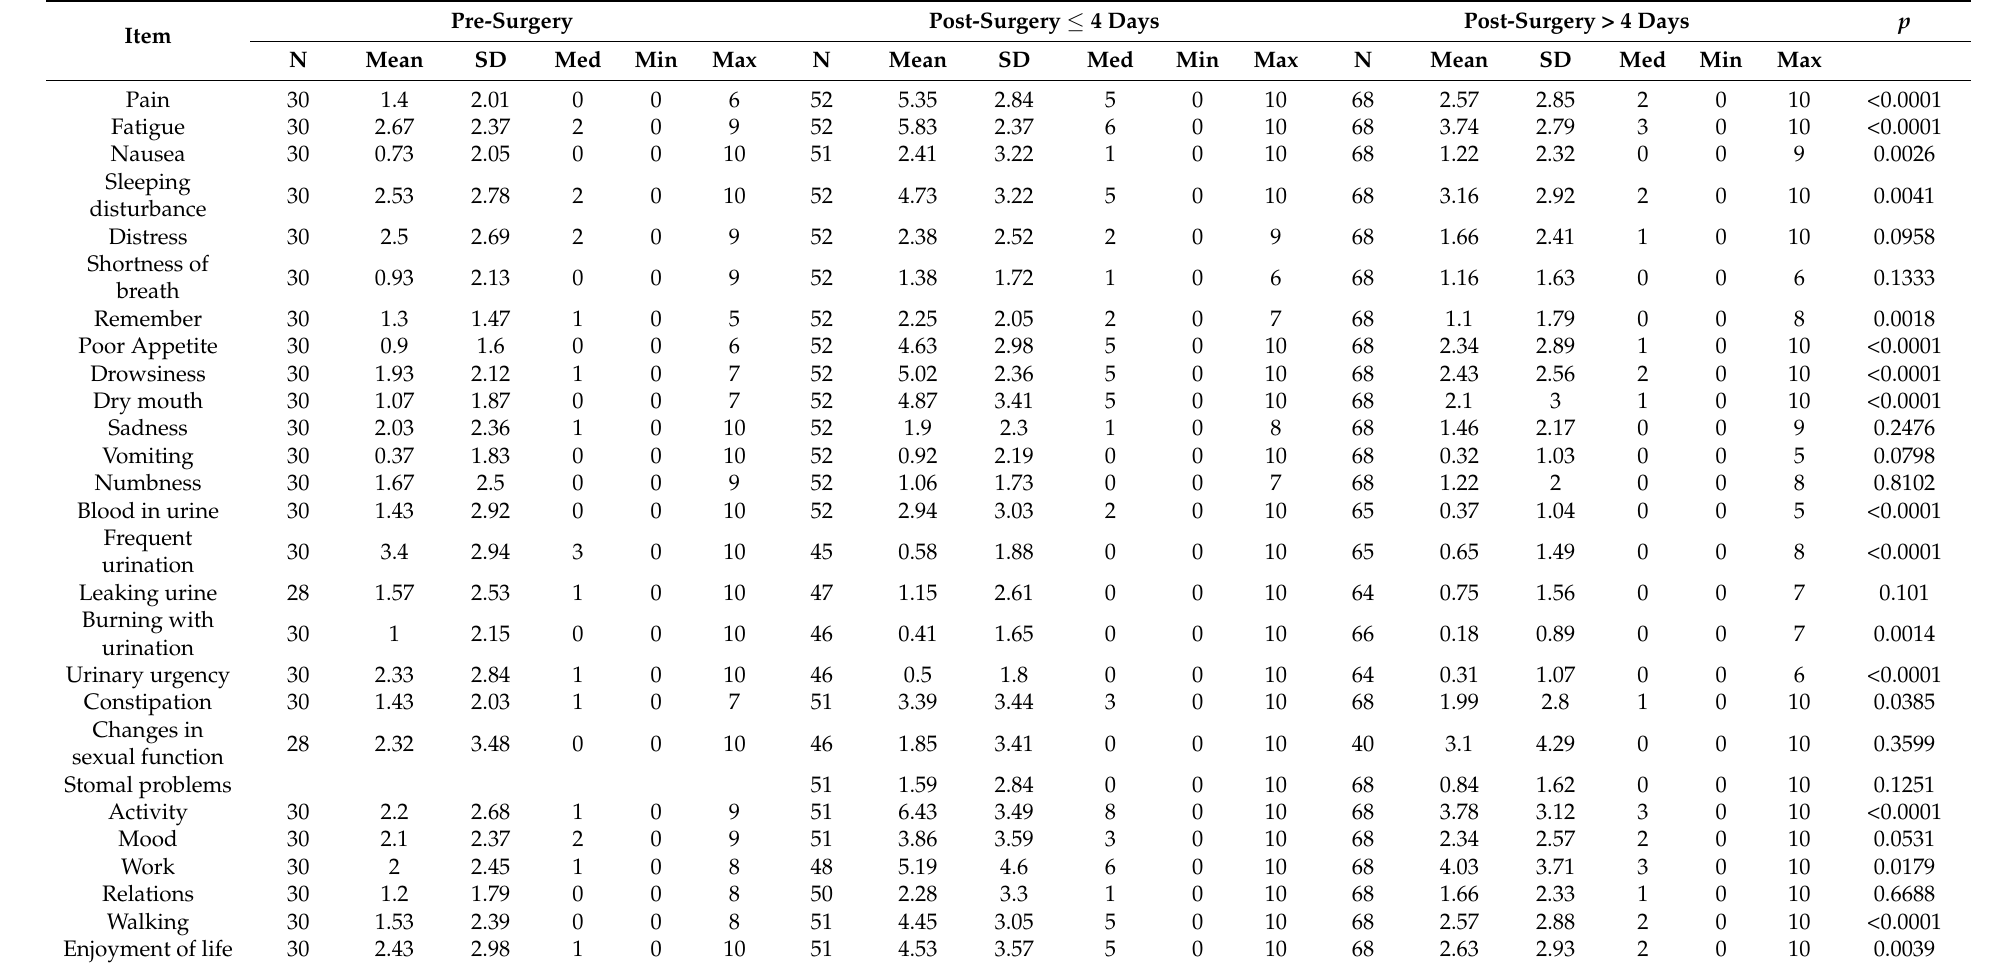
Table 5. MDASI item severity at pre-surgery and post-surgery time